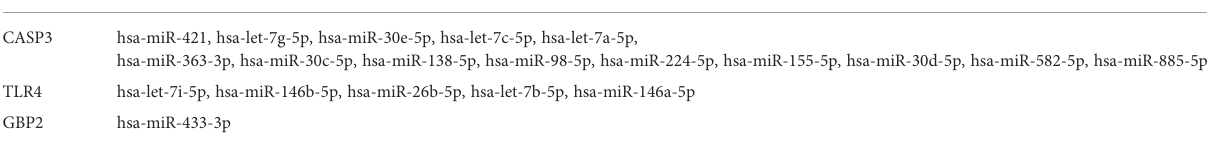
TABLE 5 miRNAs and specic targeted mRNAs in ceRNA regulatory network. mRNA